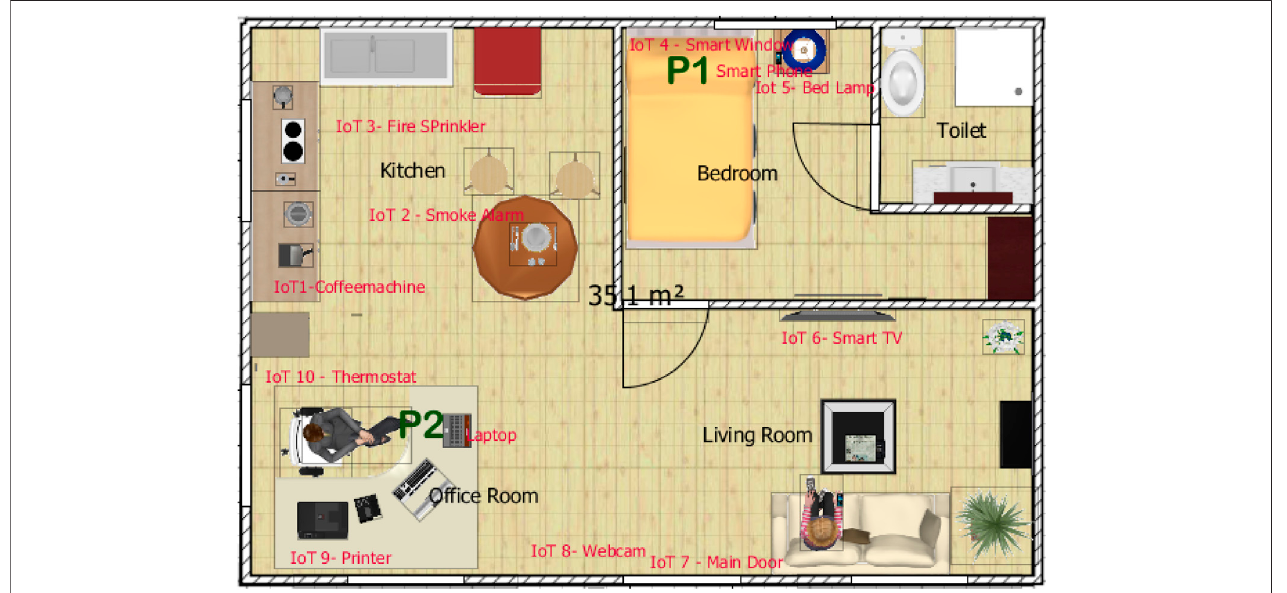
FIGURE 1 | Visual layout plan of smart indoor environment developed in Sweet Home 3D.